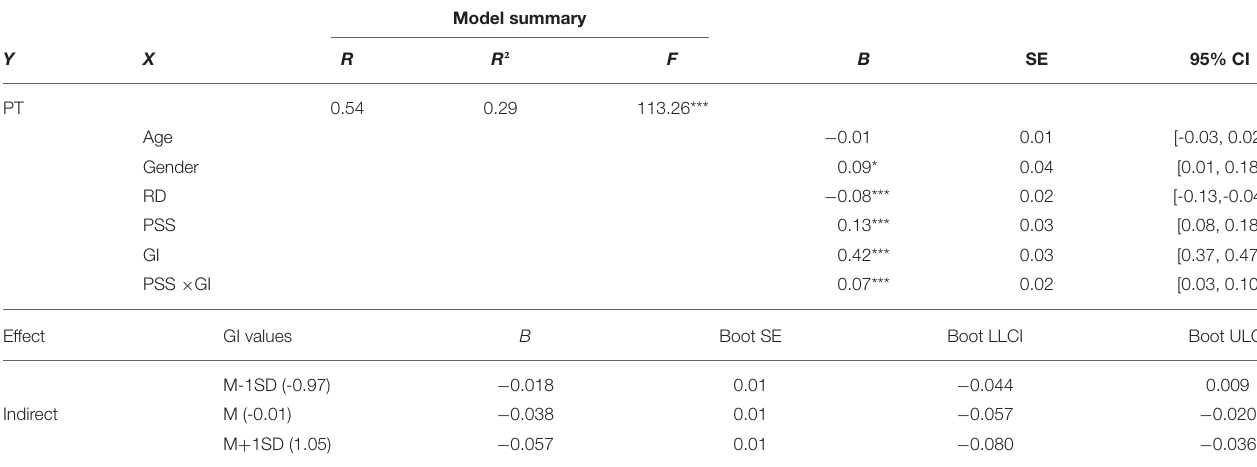
TABLE 3 | Moderated mediation analysis results with in-group identity as a moderator.